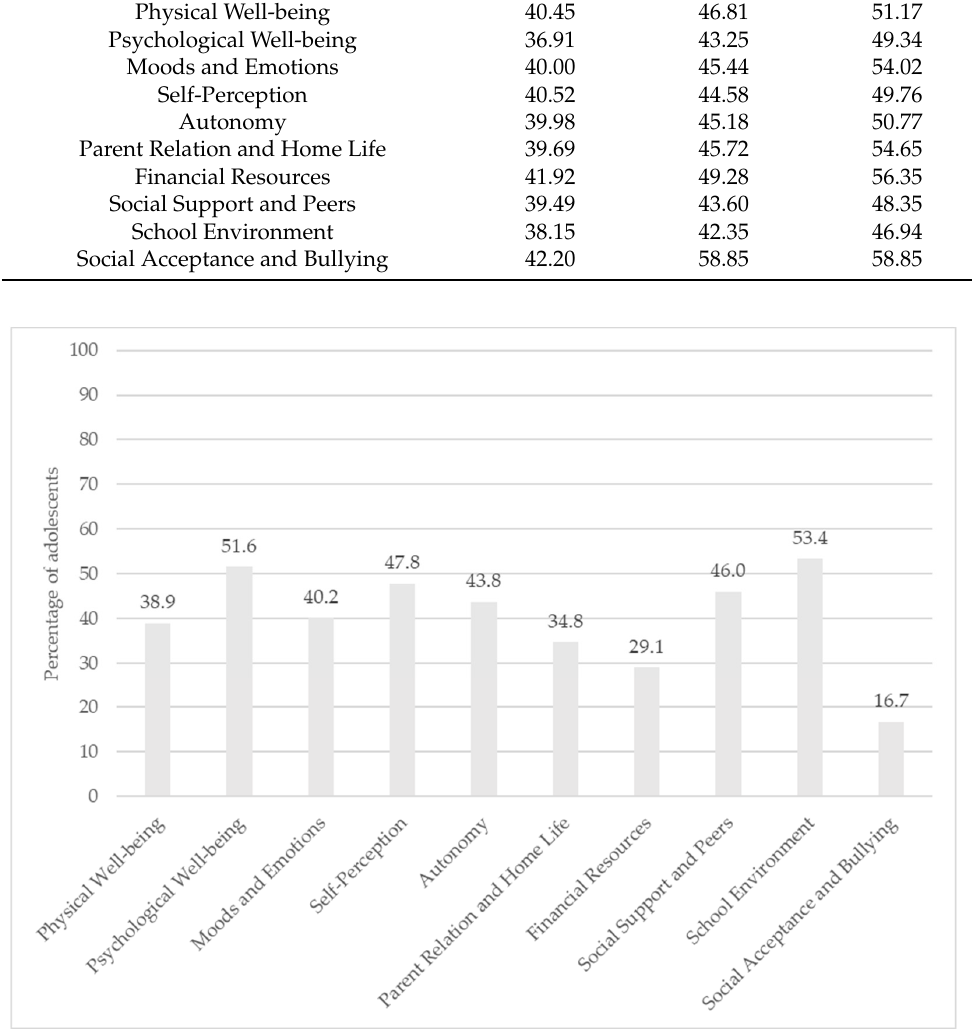
Figure 1. The prevalence of low quality of life in adolescents in 10 KIDSCREEN-52 dimensions (in percentages).